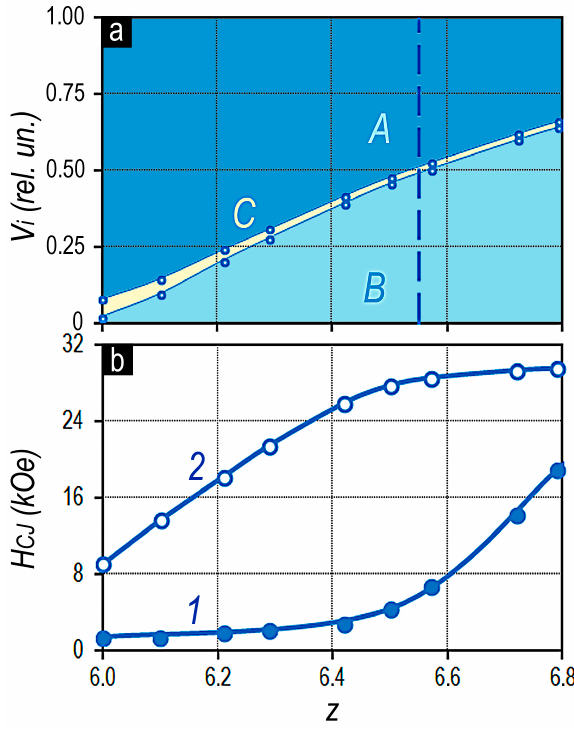
Figure 8. ( a ) Volume fractions of structural components A, B, and C (Vi) and ( b ) coercive force (H CJ ) as functions of the ratio of (4 f ,4 d )/(3 d ) elements or z of the Sm 0.85 Zr 0.15 (Co 0.702 Cu 0.088 Fe 0.210 ) Z alloys: 1—H CJ after isothermal aging at 800 ° С for 16 h and subsequent quenching and 2—H CJ after stepped aging (or slow cooling) of samples to 400 ° С .